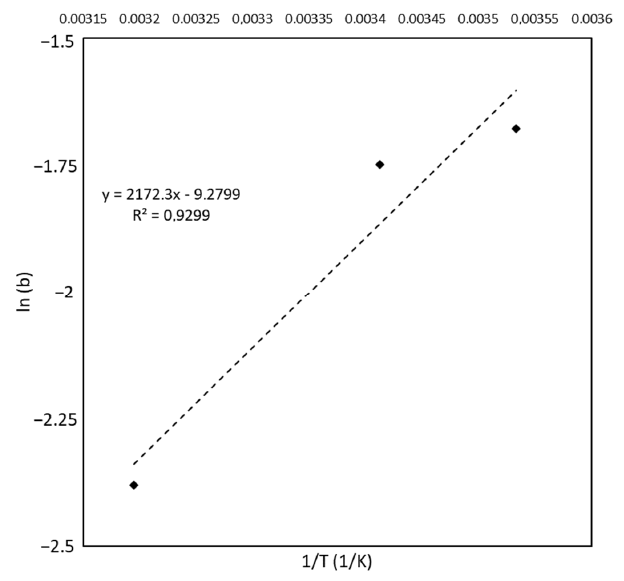
Figure 8. Natural logarithm of the Langmuir constant b versus the reciprocal of temperature. The dotted line represents the result of the linear regression, for which the equation is reported in the graph together with the value of R 2 .